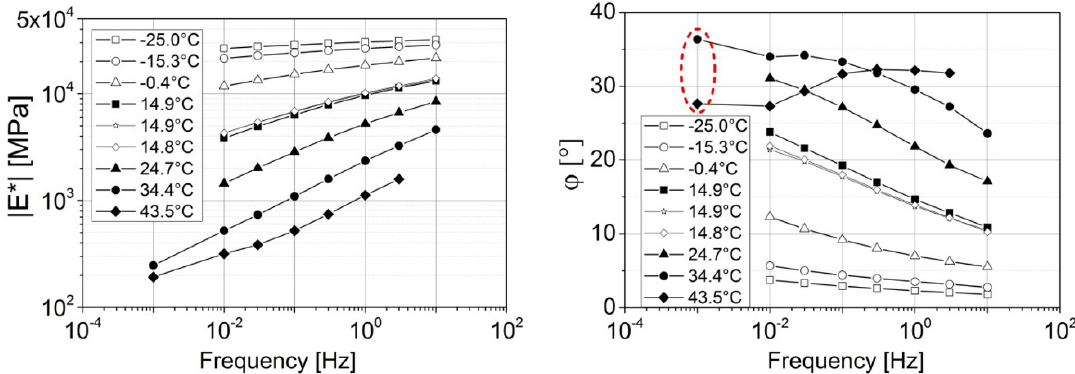
Figure 8. Experimental |E*| (left) and φ (right) isotherm curves - GB5  mixture – Dashed zone (right) corresponds to data at very low frequency and high temperature where system accuracy imply measurement error for phase angle.